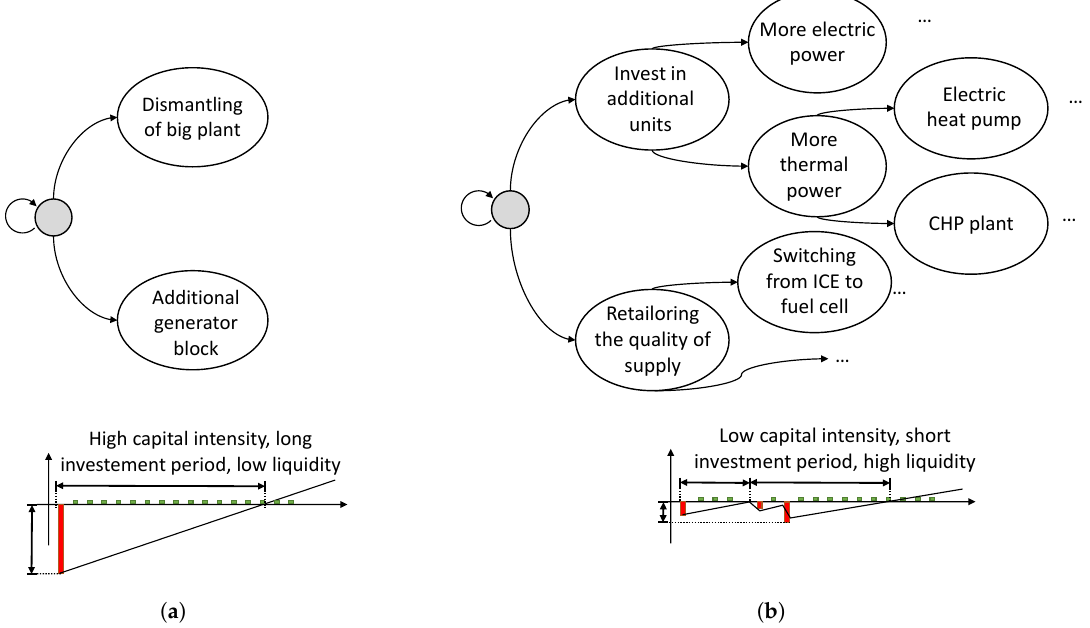
Figure 10. Availability of real options may inhibit (left) or support (right) the adaptability of a portfolio, and affects the quality of the associated investment cash flows (investment period and capital intensity). ( a ) Conventional generation: few real options, low liquidity; ( b ) This architecture: many real options, high